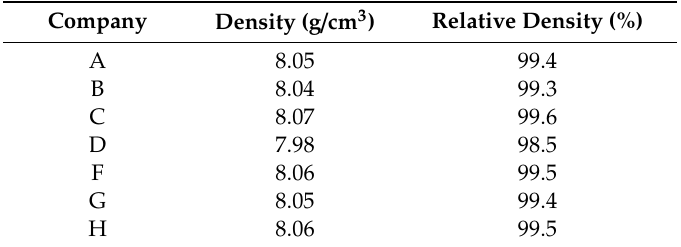
Table 10. Density and relative density for each supplier.